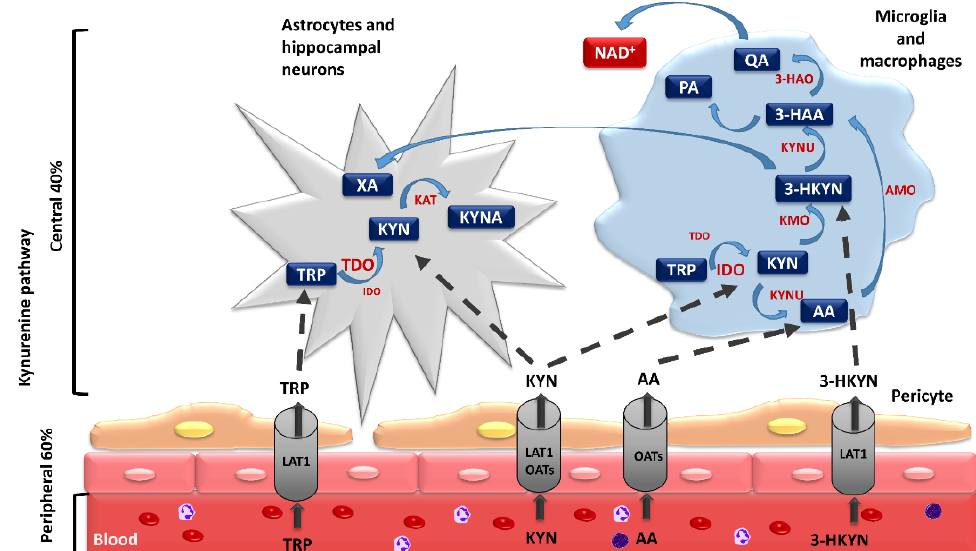
Figure 2. The course of the kynurenine pathway in various populations of the central nervous system cells. 3-HAA: 3-hydroxyanthranilic acid, 3-HAO: 3-hydroxyanthranilic acid 3,4-dioxygenase, 3-HKYN: 3-hydorxykynurenine, AA: an- thranilic acid, AMO: aminocarboxymuconatesemialdehyde decarboxylase, IDO: indoleamine 2,3-dioxygenase, KAT: kynurenine aminotransferase, KMO: kynurenine 3-monooxygenase, KYN: kynurenine, KYNA: kynurenic acid, KYNU: kynureninase, LAT-1: large neutral amino acid transporter 1, NAD+: oxidized form of nicotinamide adenine dinucleotide, OATs: organic anion transporters, PA: picolinic acid, QA: quinolinic acid, TDO: tryptophan 2,3-dioxygenase, TRP: tryptophan, XA: xanthurenic acid.